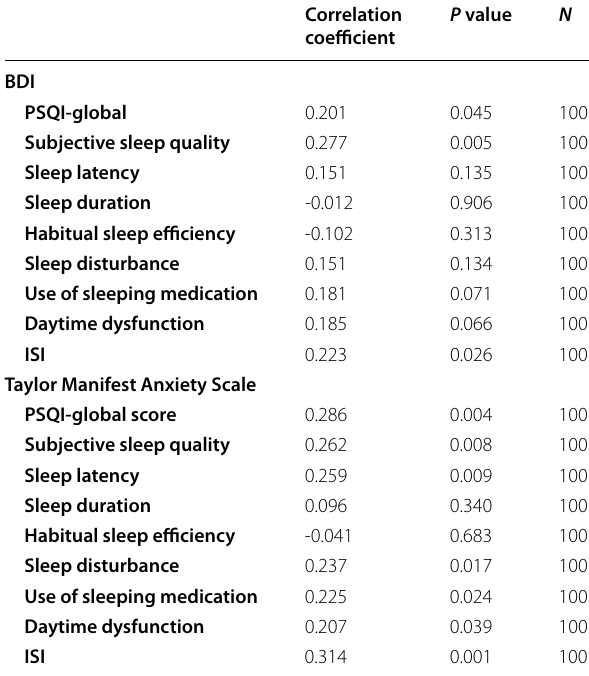
Table 5 Correlation between BDI and Taylor Manifest Anxiety scale with PSQI global and all its subscales and Insomnia Severity Correlation